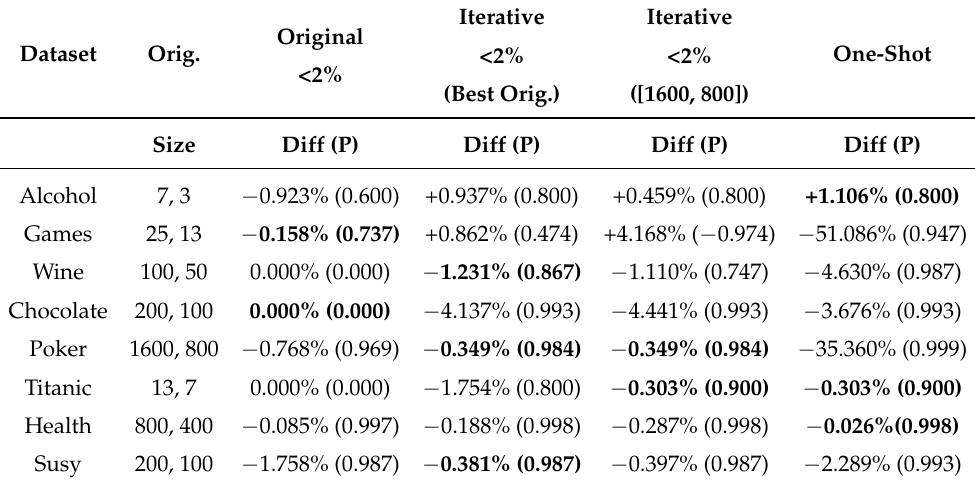
Table 6. Best models selected by size with less than 2% divergence in accuracy of the original model. For each dataset (first column), we noted the size of the original model in the second column. Then we show the smallest possible model with <2% divergence in accuracy for each of the original, iterative on best original, iterative on [1600, 800], and finally one-shot. The table shows the percentage difference in RMSE or F1, and P the prune rate compared to original. If the difference in accuracy is >2%, then that was the best performing model accuracy-wise and we could not produce a valid smaller model using that approach. Bold is the smallest model which does not exceed the 2% divergence in accuracy